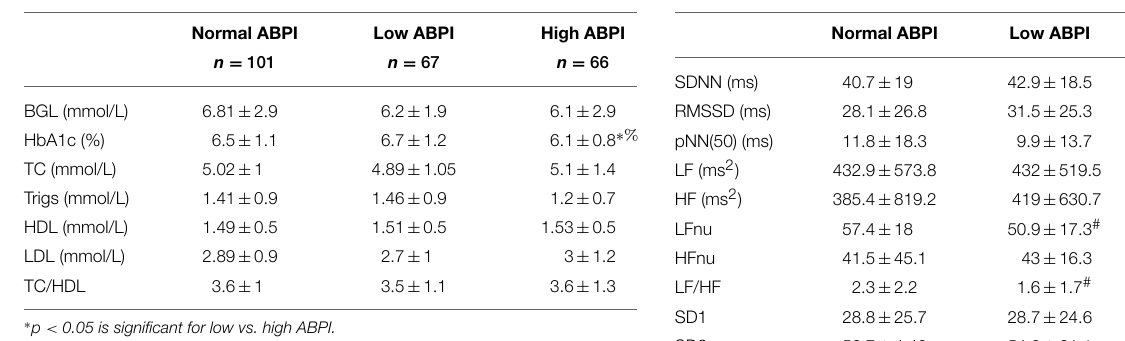
TABLE 3 | Differences in measured HRV between those with normal, low and high